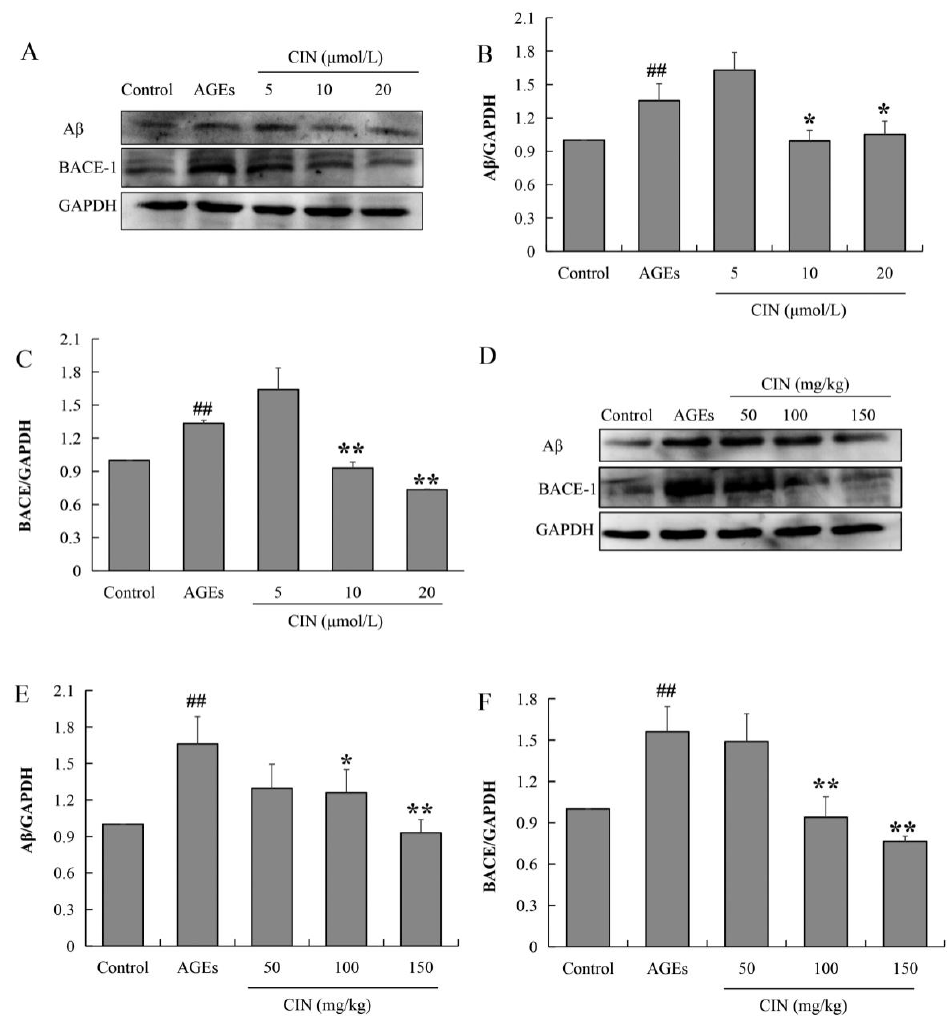
Figure 6. Effects of CIN on A β production and BACE expression in vitro and in vivo. ( A – C ) The protein levels of A β and BACE in SH-SY5Y cells were detected by Western blot. n = 3. ( D – F ) The protein levels of A β and BACE in rat hippocampus were detected by Western blot. n = 8. ## p < 0.01 compared with the control group; * p < 0.05, ** p < 0.01 compared with the model group.